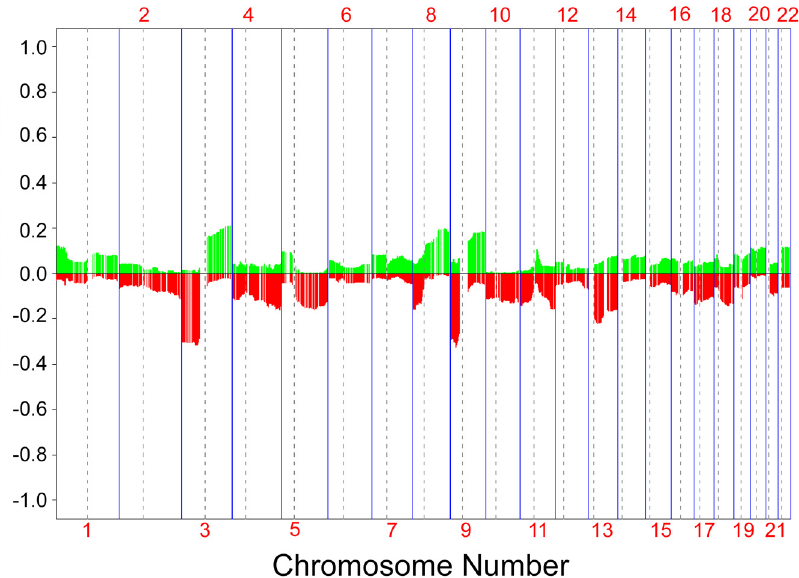
Figure 1. Frequency of aCGH aberrations in skin tumors. A frequency plot of somatic aberrations identified in 305 skin tumors by aCGH is shown. Each line is an individual BAC clone. Green indicates gain and red indicates loss. Clones are ordered from chromosome 1 through 22. Tumors profiled are from 181 patients with one or more independent SCCs and/or KAs.